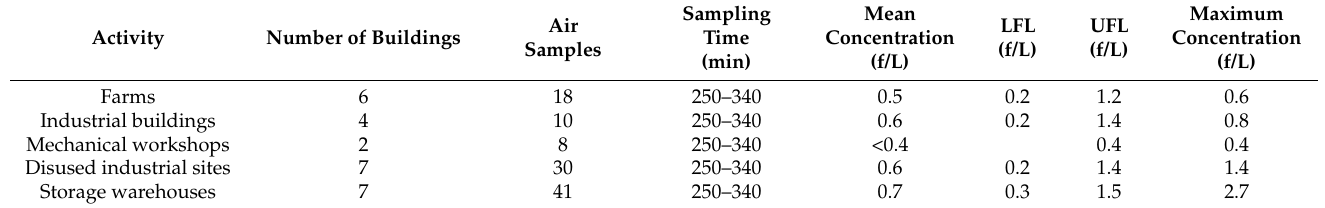
Table 4. Mean airborne asbestos fiber concentration measured in buildings other than public offices with non-friable ACMs. LFL, UFL and maximum concentration measured are also